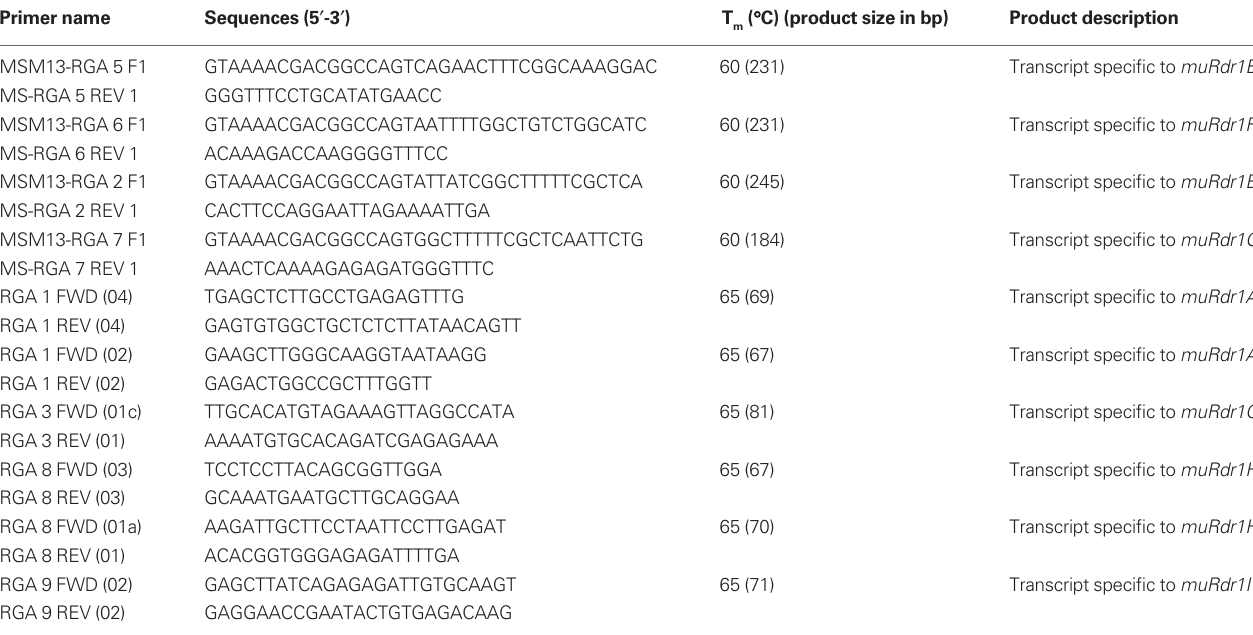
Table A1 | List of primers utilized for expression analysis of TNL genes.